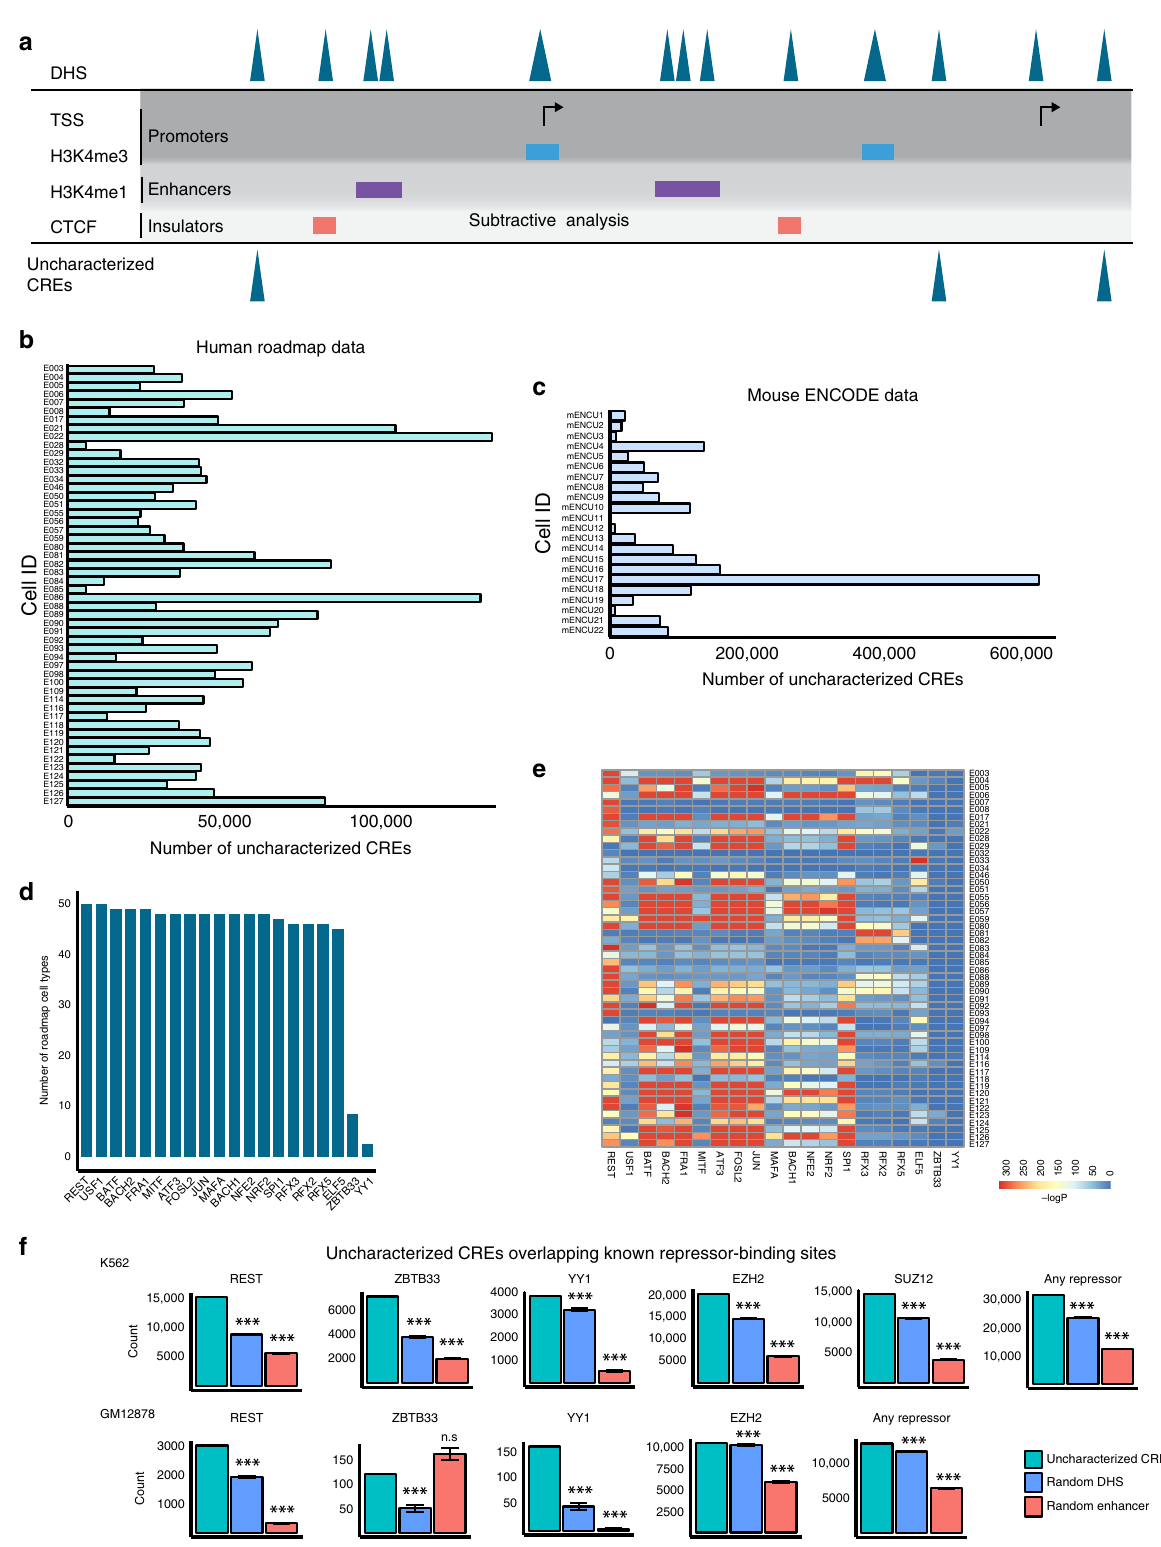
Fig. 1 Overview of uncharacterized CREs in human and mouse. a Schematic of the simple subtractive analysis (SSA) approach. Barplots presenting the count of uncharacterized CREs across different cell types and tissues in human from Roadmap ( b ) and mouse genomes from ENCODE ( c ). d Bar plot presenting the count of cell types enriched with TF motifs across 52 cell types and tissues from Roadmap. e Heatmap of enrichment (-log(P-value)) of TF motifs across 52 cell types. f Barplots presenting the count of uncharacterized CREs, random DHS and random enhancers at known repressor TFBS based on ChIP-seq data in K562 and GM12878 cell types. *** indicates permutation test P -value < 0.0001, and n.s. denotes not signi fi